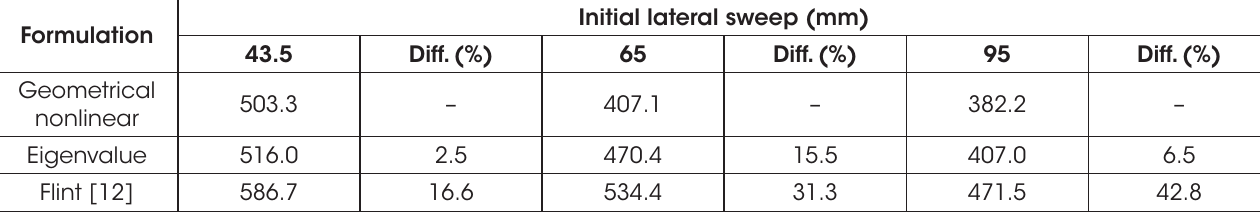
Comparison between numerical and analytical solutions of instability load